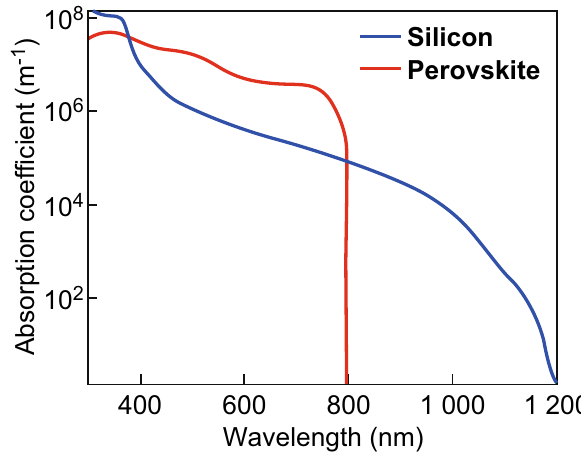
Fig. 7 Absorption coefficients of crystalline silicon and MAPbI 3 per-